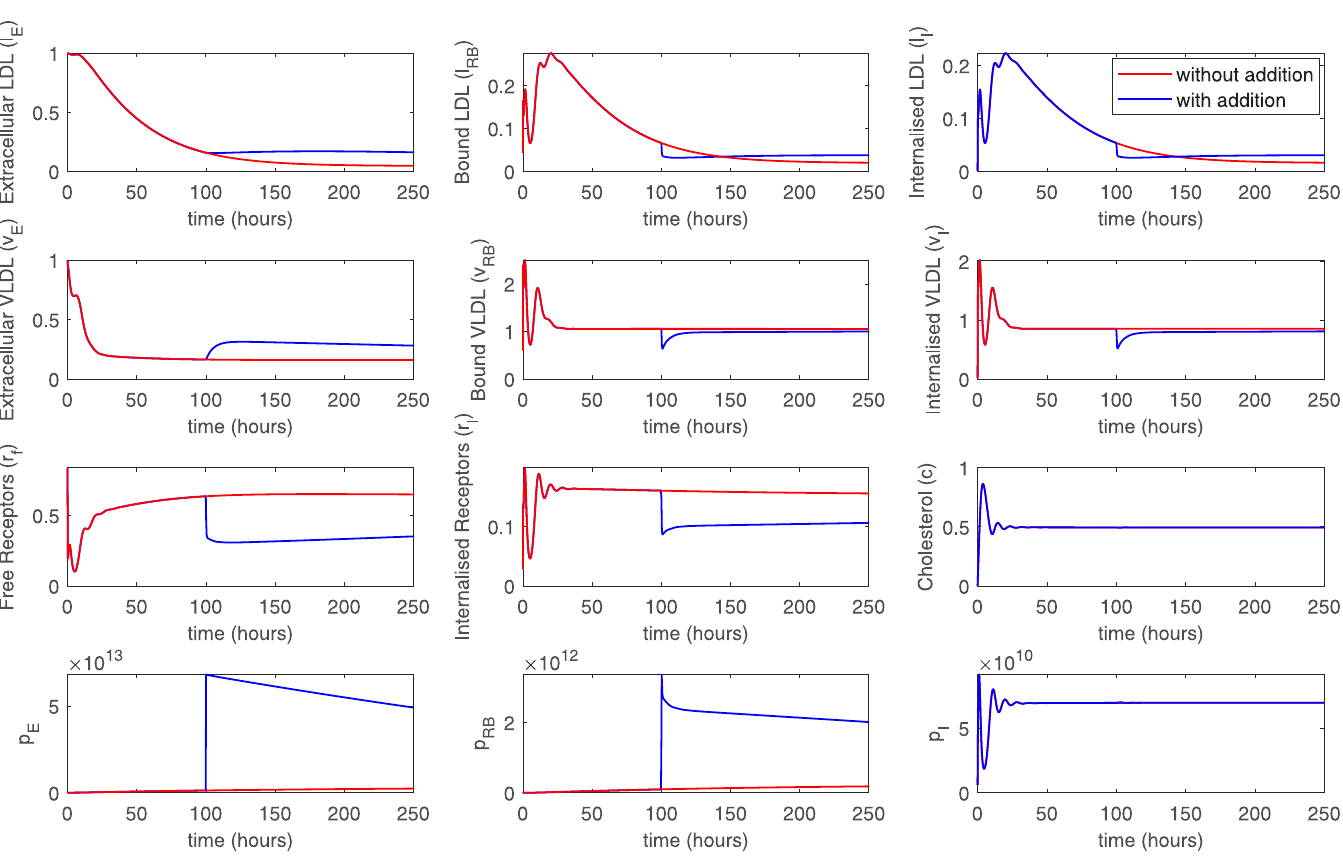
Fig 4. A simulation showing the effect of the addition of external PCSK9 at a predefined time point (100h). While the cells did not produce enough PCSK9 for the pronounced effects, the addition of external PCSK9 causes changes in LDL and VLDL levels.